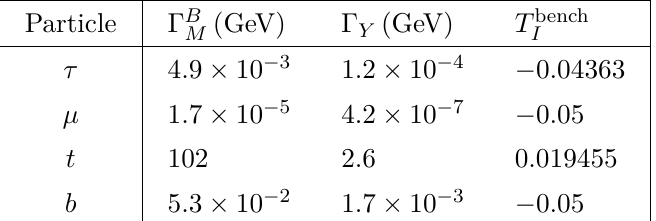
(in the broken phase), Γ Y (for the both phases) as given by M I